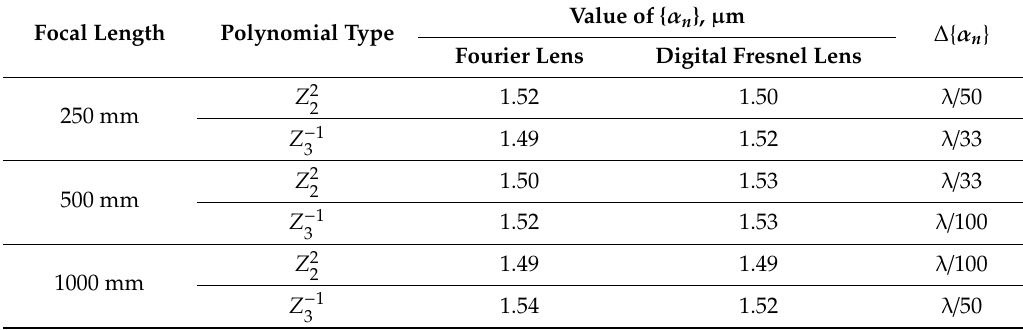
Table 1. The result of wavefront aberrations measurement for two di ff erent